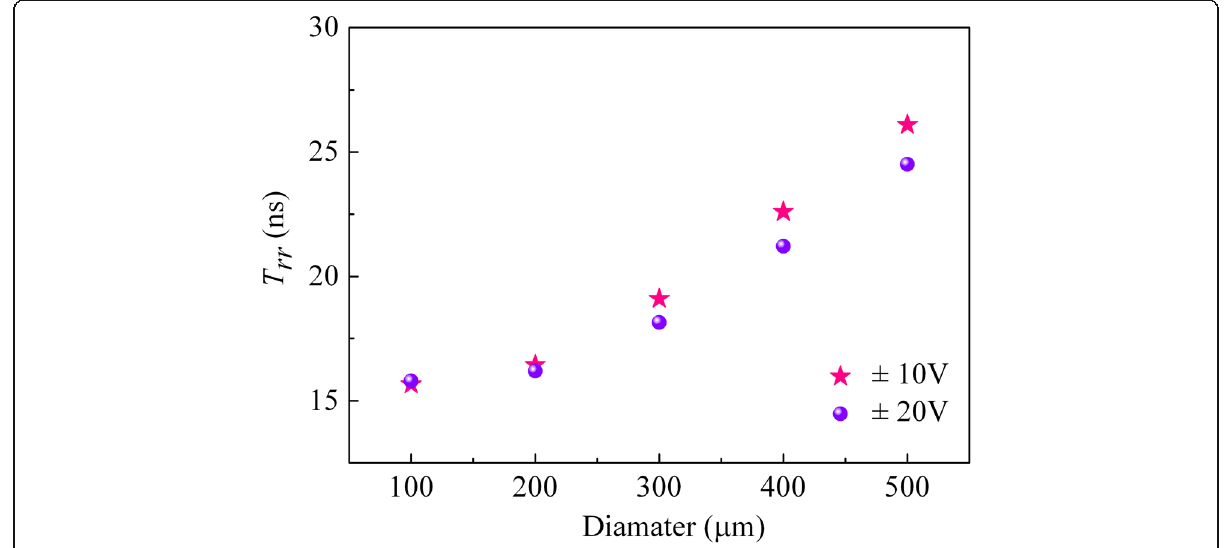
Fig. 5 Reverse recovery time T rr versus electrode diameter